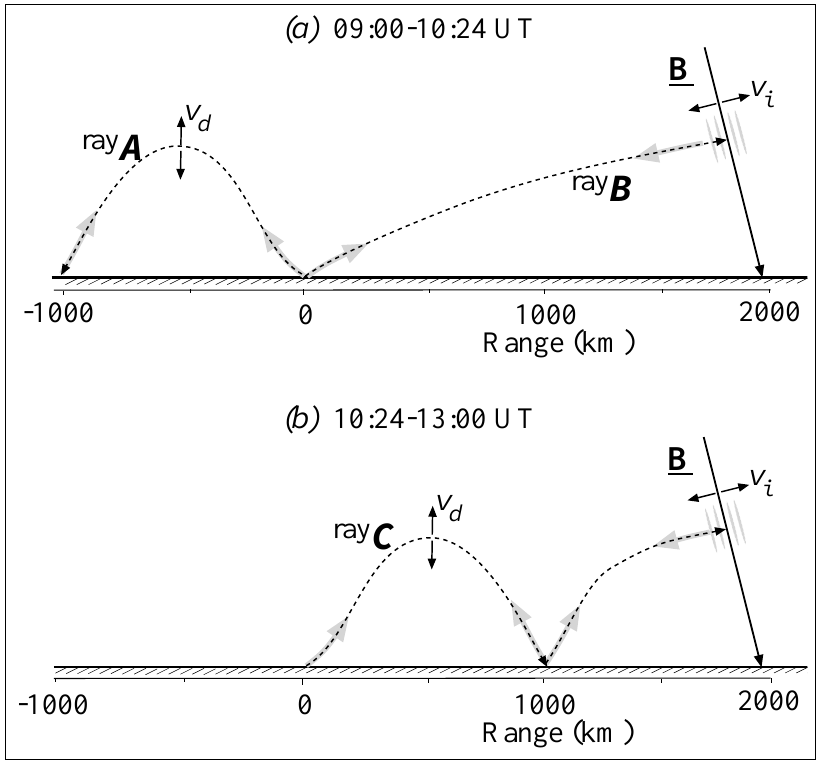
Fig. 9. Likely ray paths for the Finland radar. (a) 09:00–10:24UT. Ray A rep- resents ground scatter reflected from the F-region behind the radar, and experi- encing ionospheric Doppler oscillations v d . Ray B represents ionospheric scat- ter from the cusp F-region, with line-of- sight Doppler velocity v i . (b) 10:24–13:00UT. Ray C represents simultaneous F-region reflected ground scatter and 1.5 hop mode ionospheric scatter from the auroral